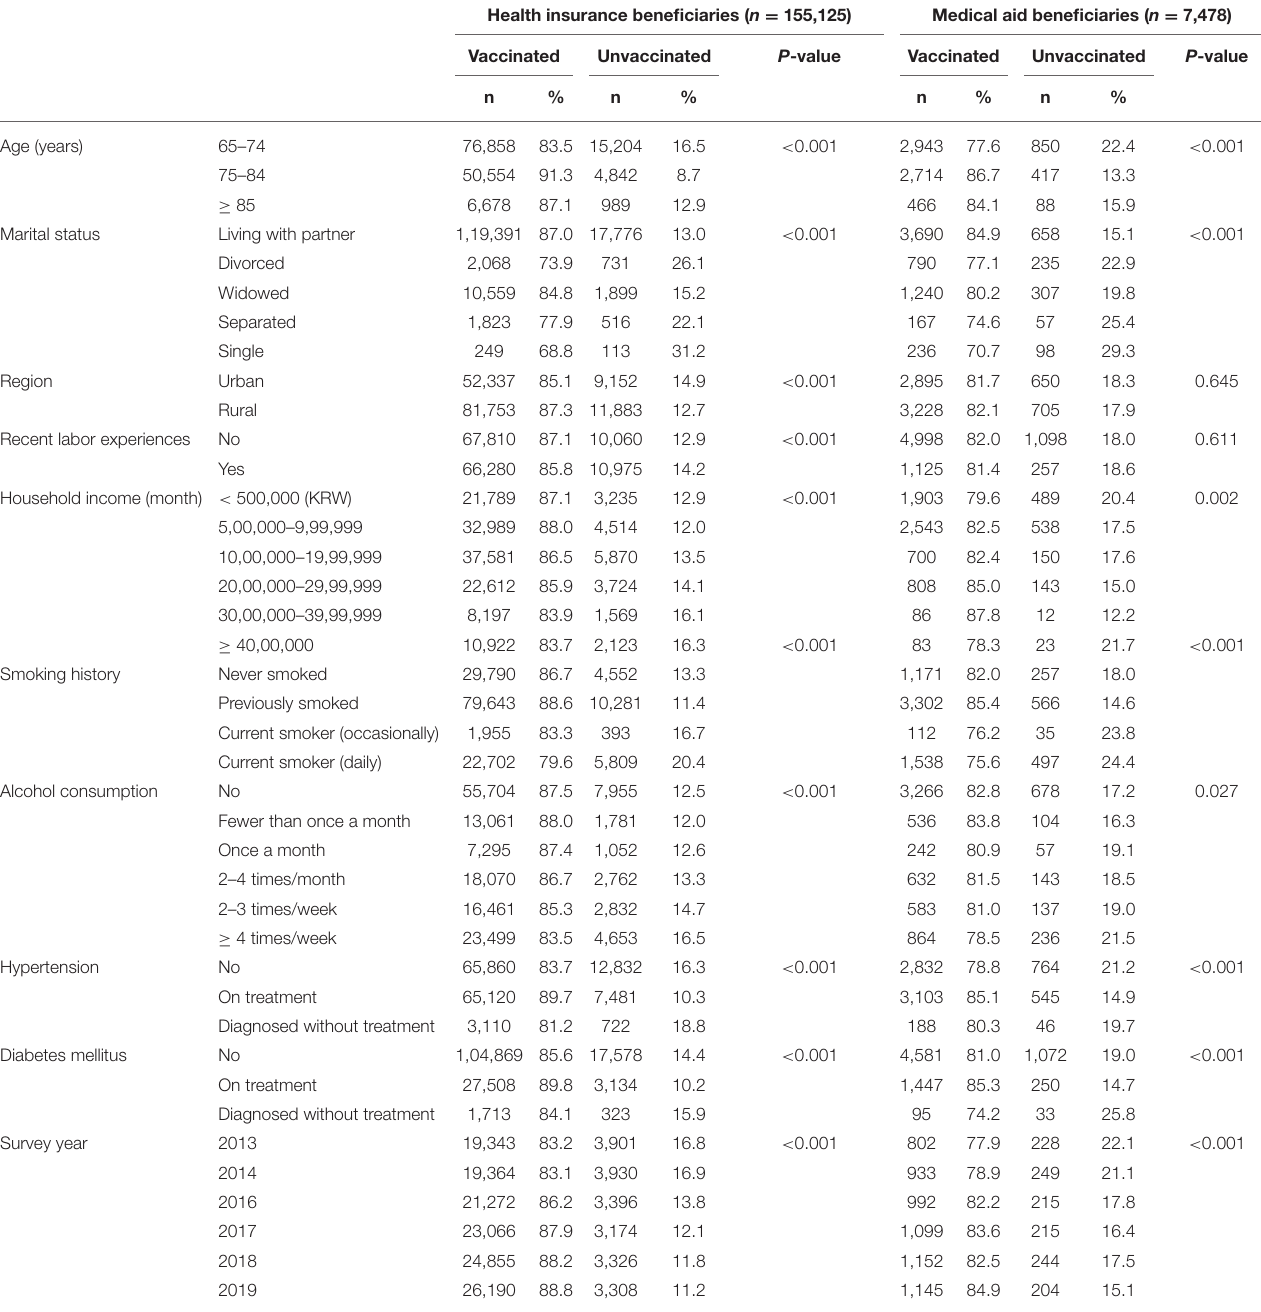
TABLE 2 | Vaccination rates among male participants based on different baseline characteristics stratified by type of health